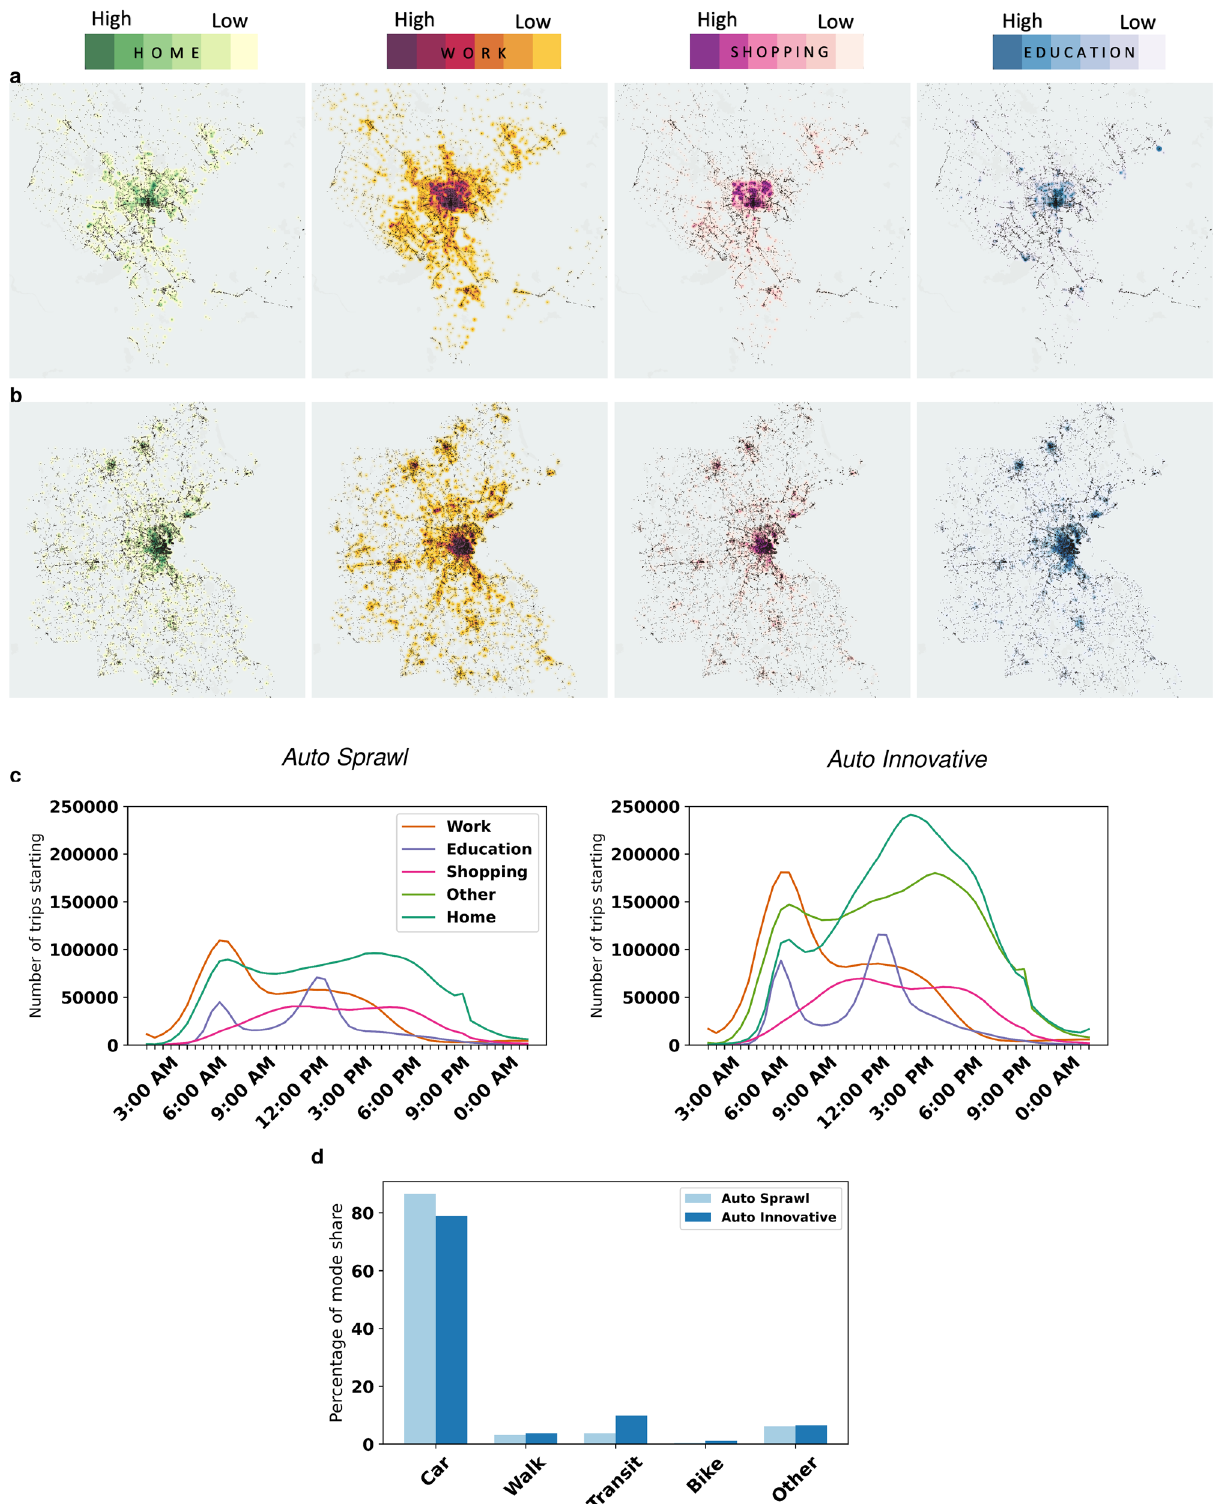
Figure 2. Activity and mobility patterns in two prototype cities. Spatial distribution of activity locations in ( a ) Auto Sprawl , and ( b ) Auto Innovative . The radii of heat maps are the same across both the cities; ( c ) Number of trips starting at various 30-minute intervals during the day; ( d ) Mode share for the two cities. Daily number of trips in Auto Sprawl is 9.72 × 10 6 , while in Auto Innovative it is 16 × 10 6 . Both cities have a similar trip generation rate of 3.5 per